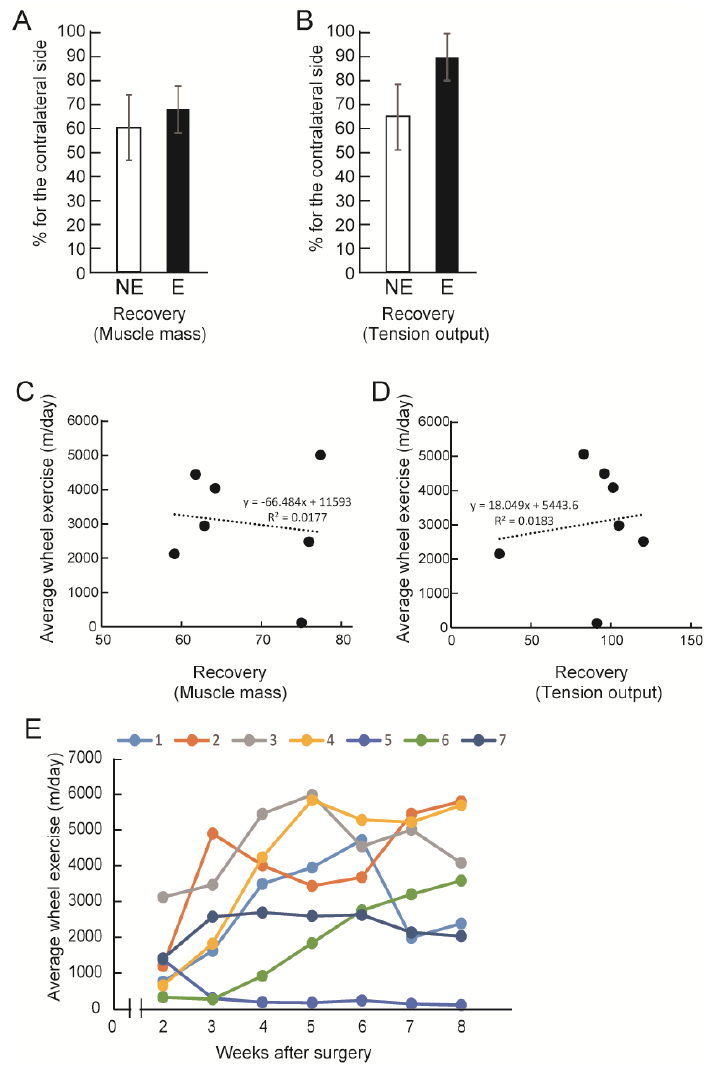
Figure 2. Recovery of downstream muscle mass and tension output, and individual exercise statistics. ( A ) Recovery of total muscle mass (gastrocnemius (GAS) + plantaris (PLA) + combined soleus (SOL)); ( B ) Recovery of tension output of the three muscles. Both markers are calculated based on the contralateral side. The E group consistently shows better recovery than the NE group; ( C ) Relationship between average wheel exercise (m/day) and muscle mass recovery; ( D ) Relationship between average wheel exercise (m/day) and muscle tension recovery; ( C , D ) shows individual plots, and there are no correlations; ( E ) Individual shift of exercise volume during recovery term.